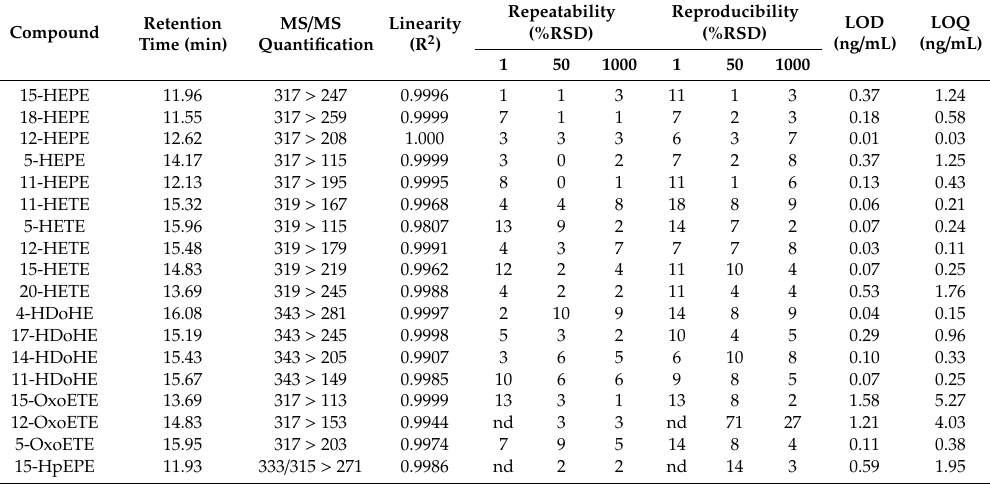
Table 1. Retention times. MS / MS quantification transitions ( m / z ). Linearity by least-squares